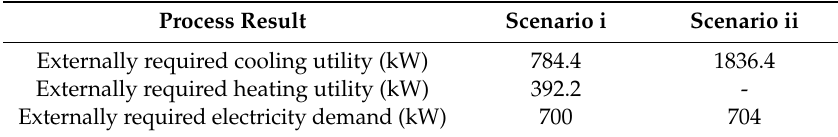
Table 4. External utility requirements of the conversion processes, assuming full heat